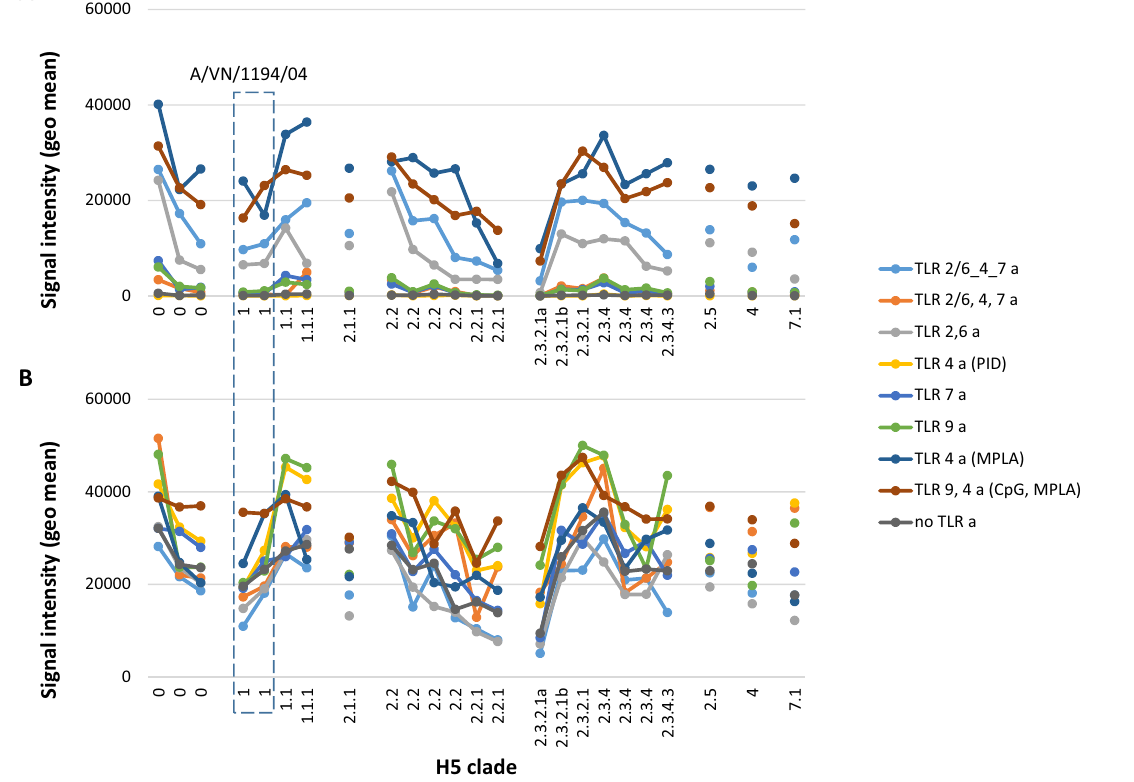
Figure 3. Cross-clade homosubtypic cross-reactivity measured by protein microarray. IgG profiles in response to trimerized influenza virus VN04 (A/VN/1203/2004) H5 vaccine formulated with different TLR agonists, with or without squalene oil-in-water emulsion (AddaVax). H5 antigens (horizontal axis) are full-length (HA0) HA variants that have been organized by clade (classifications from www. fludb. org). Signal intensities (vertical axis) are geometric means of each vaccine group (N = 4 mice). ( A ) minus AddaVax; ( B ) with AddaVax. Boxed, two VN04 H5 proteins on the array (expressed in human or insect cells) that correspond with immunizing H5 variant. Abbreviations, as Fig.